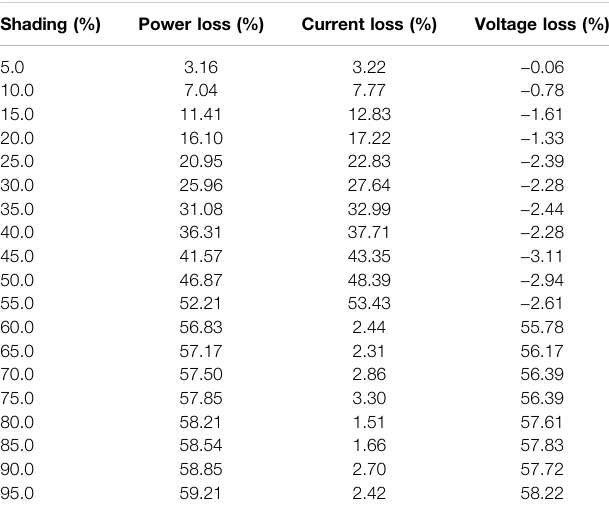
TABLE 7 | Annual power, current and voltage losses. Shading